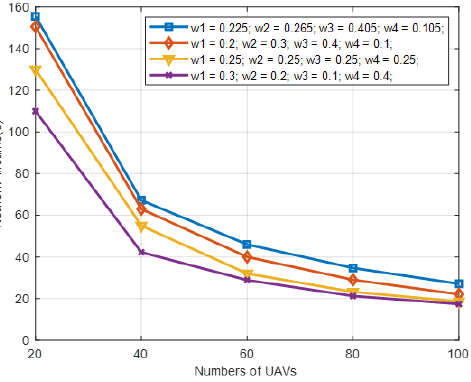
Figure 8. Network lifetime in different weight settings with varying numbers of UAV nodes in IWLC scheme.